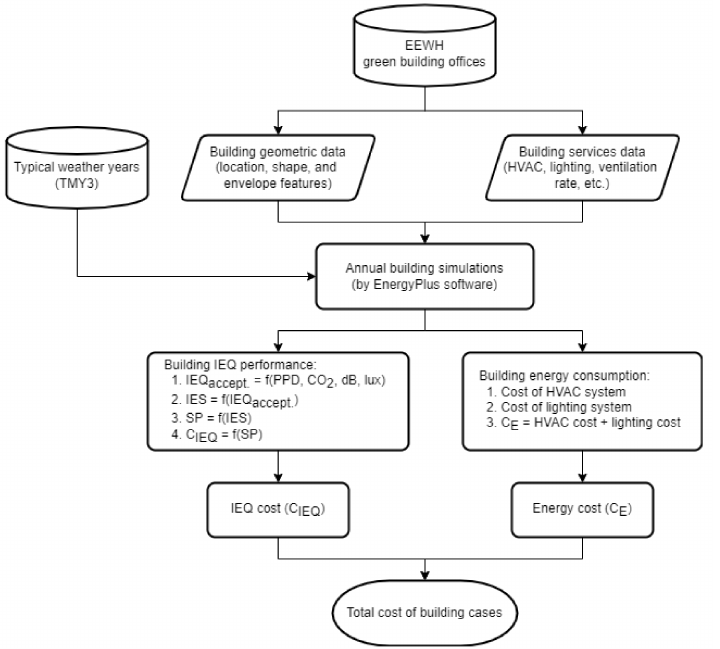
Figure 1. The flowchart of this study used for investigating IEQ and energy costs in green